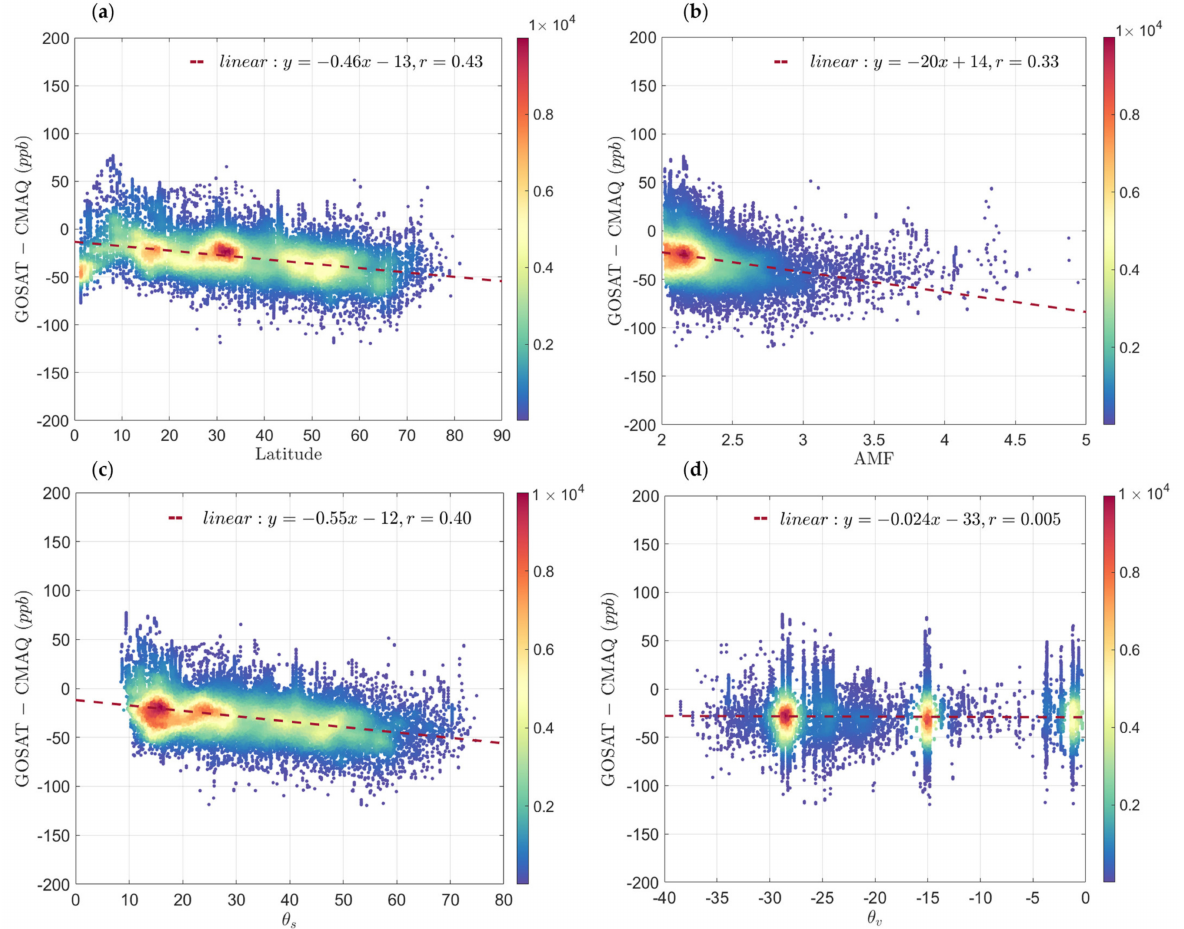
Figure 4. Linear regression fit of the difference between GOSAT observation and H-CMAQ simulated XCH4 as a function of ( a ) latitude, ( b ) air mass factor (AMF), ( c ) solar zenith angle, θ s , and ( d ) satellite viewing zenith angle, θ v . The colorbar indicates the number of GOSAT observations, with a higher observations density in